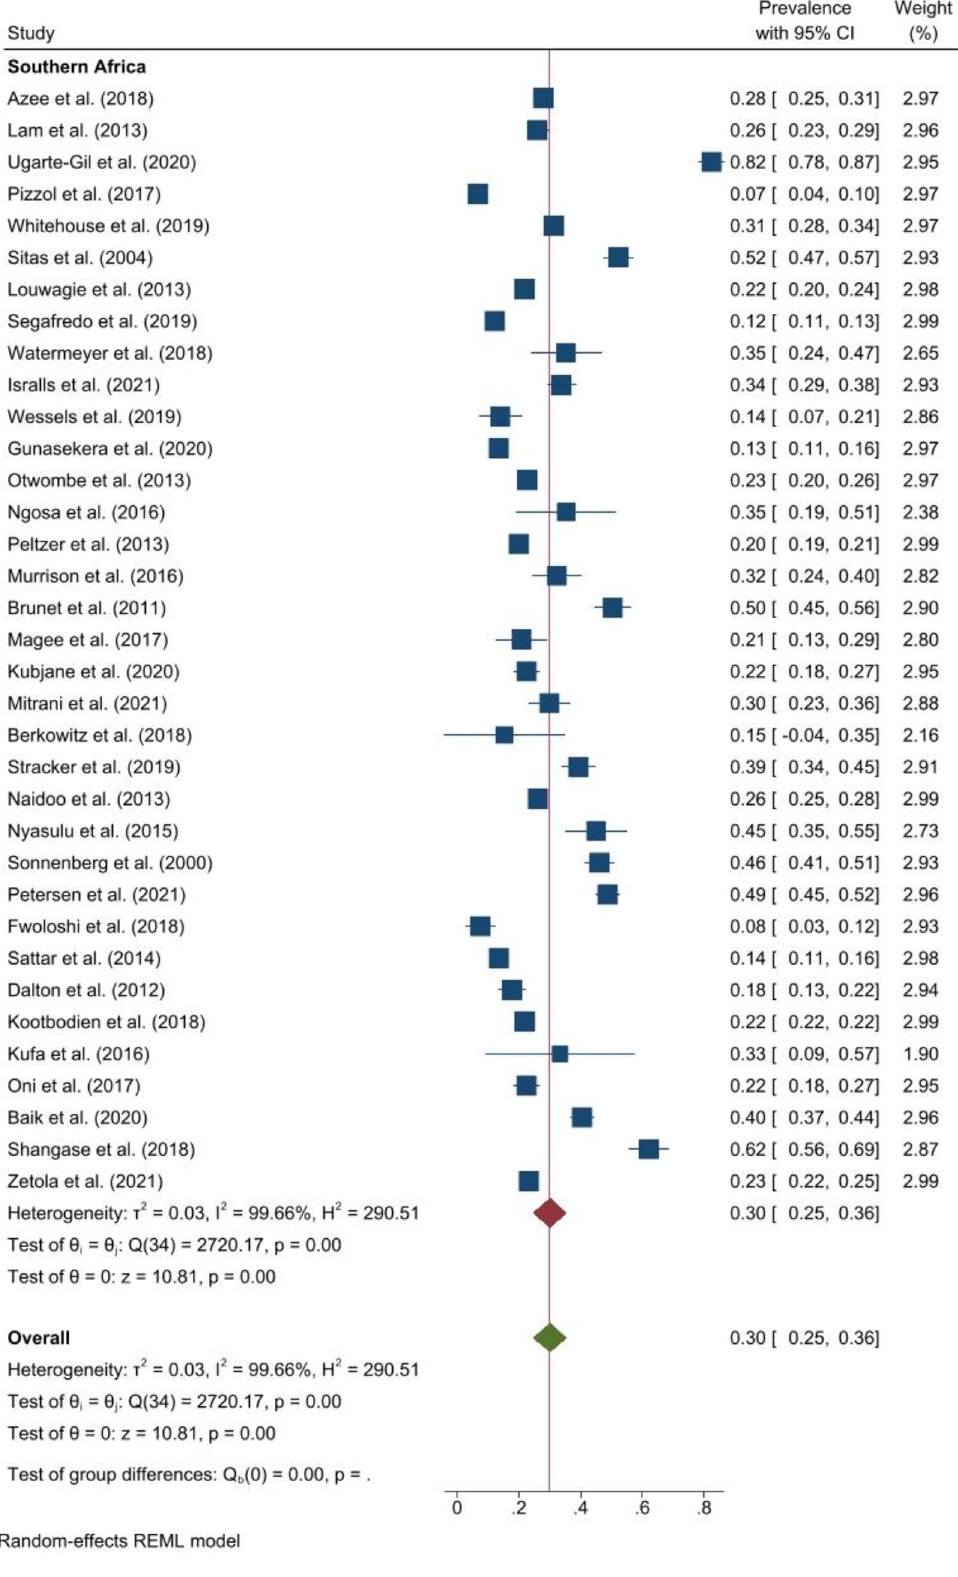
Figure 1. Forest plot showing the pooled prevalence of smoking among people with active TB in Southern